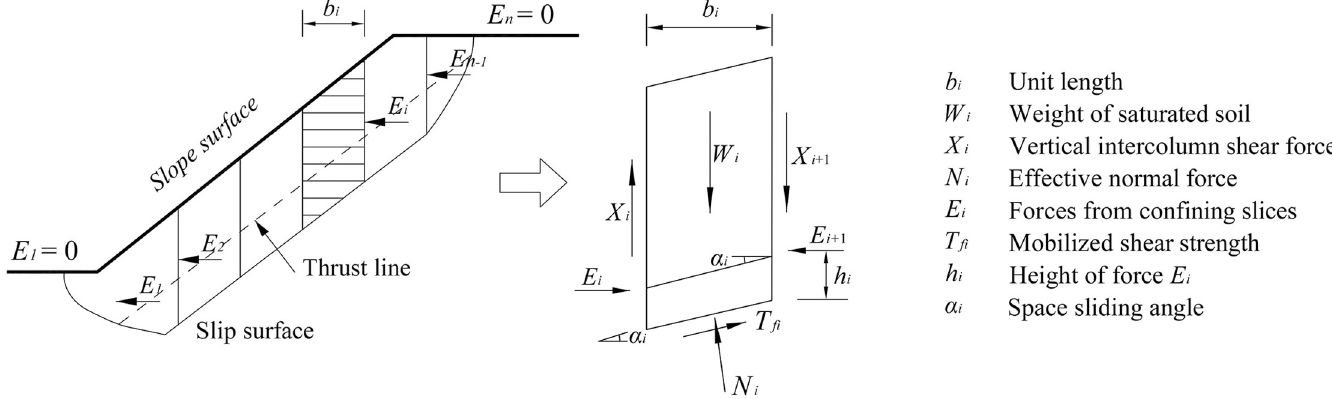
Fig 6. Basic principles of the Janbu slice